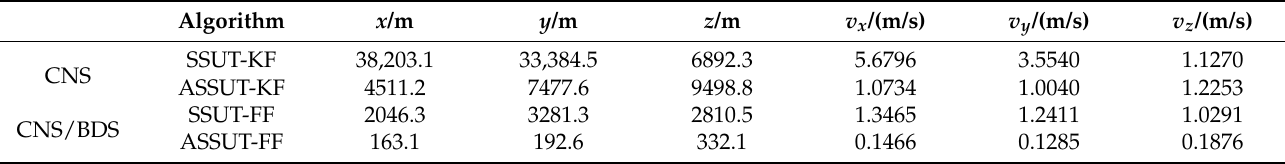
Table 10. RMSEs of position and velocity in three directions in the uncertain noise region.